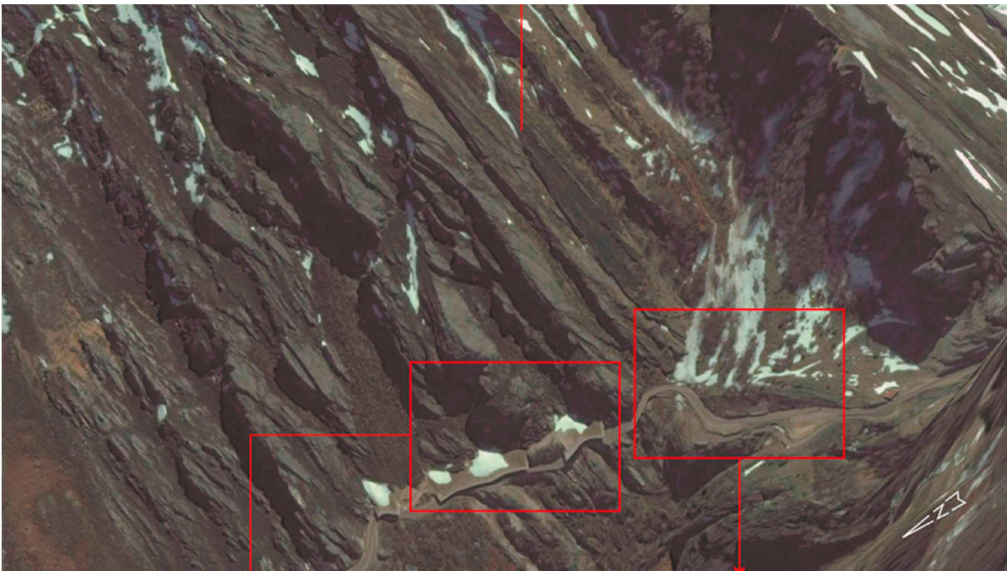
Figure 10. Google Earth image of the headwaters of the San Isidro River, taken on 9 May 2015. Note the presence of the remains of the snow avalanches, which have taken advantage of the verticalised ridges of the quartzite layers to slide along this stretch of the river, on the visors built on the access road to the pass. In the lower part of the image, in the red box on the left, detail of the visors or false tunnels, installed in 2009 and, in the one on the right, the succession of flexible avalanche barriers placed in the valley of Valverde, which have proved ineffective in containing the avalanches. Photograph by the authors. Focus with camera on Figure through Onirix site or use the link